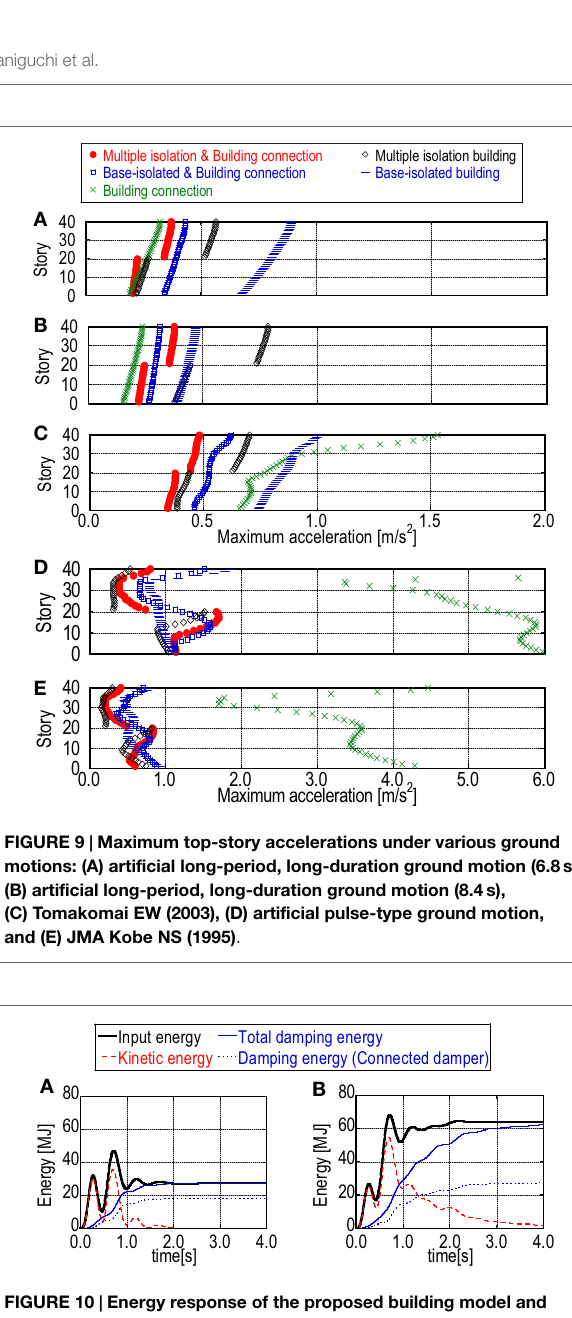
FIGURE 10 | Energy response of the proposed building model and other comparable model under the artificial pulse-type earthquake ground motion: (A) proposed model (multiple isolation and building connection model) and (B) building connection model (without isolation) .